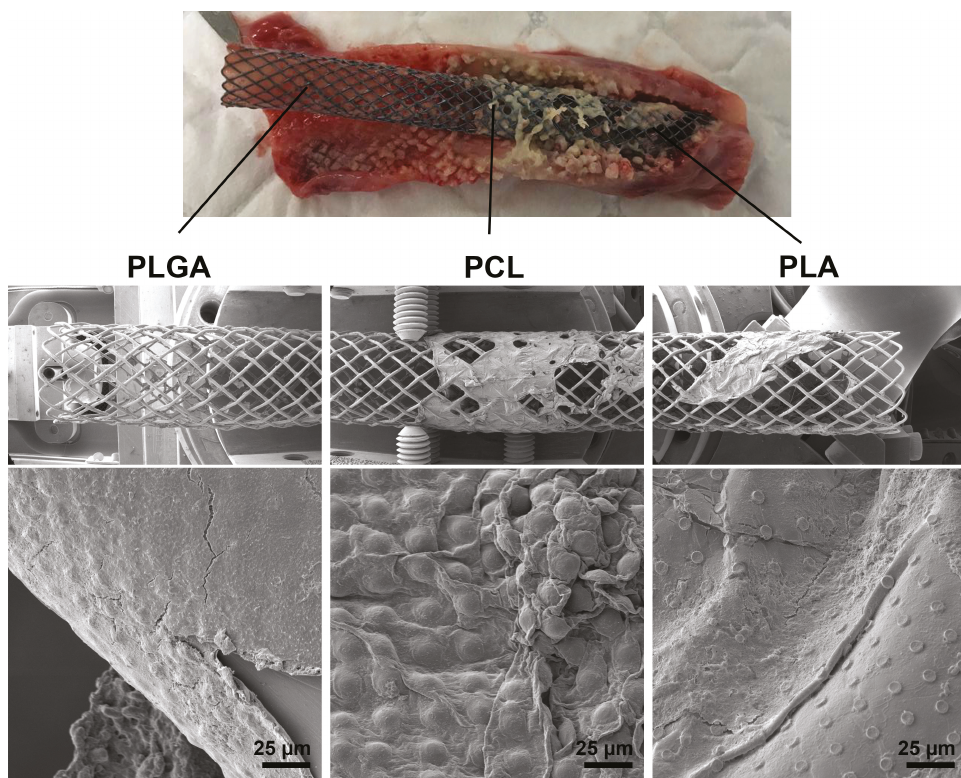
Figure 6. Biodegradation of PLGA, PCL, and PLA-based coatings 10 days after stent implantation in rabbit trachea. Photo of the trachea with a stent on top, SEM images of the coatings on the bottom.